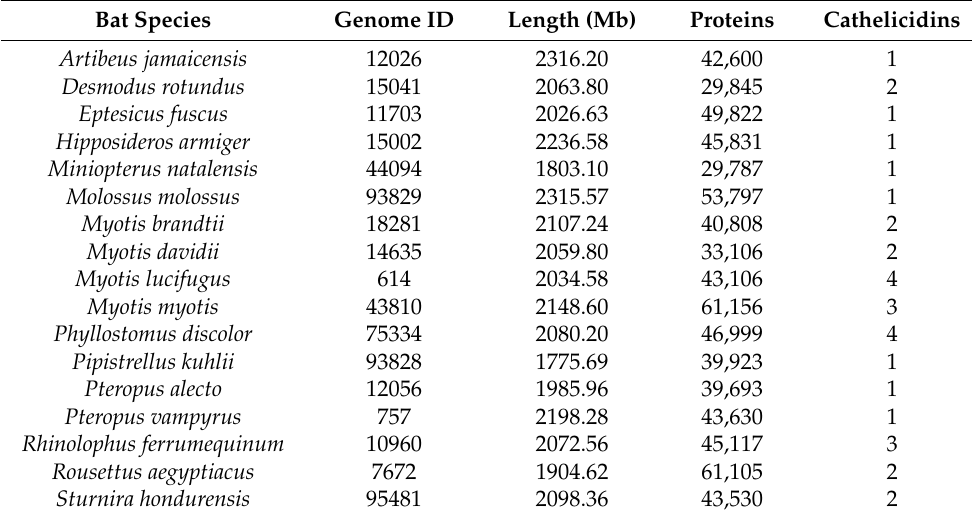
Table 1. Number of predicted unique cathelicidin proteins found for each bat species that have on-going sequencing projects by February 2021, in comparison with the median genome length and protein counts. Source: NCBI database